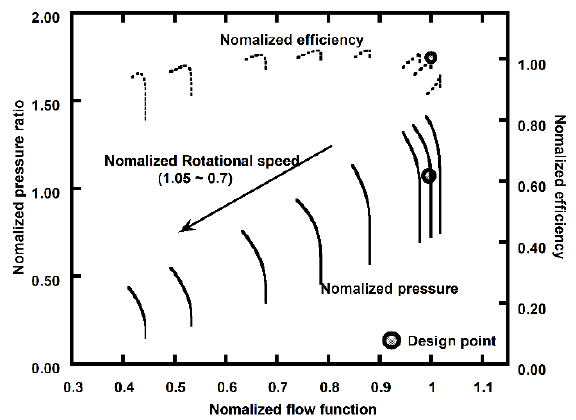
Figure 3. Compressor performance map.